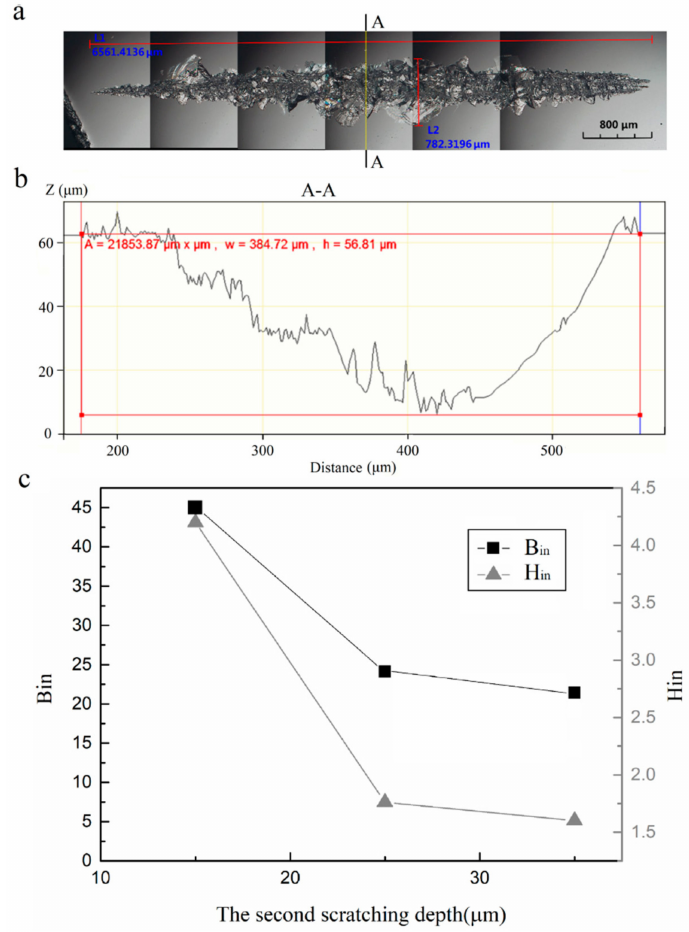
Figure 2. Three-dimension morphology of the groove after scratching by two diamond grain with di ff erent Z-axis spacings along the depth of cutting (DOC) direction, ( a ) morphology of the groove Iwith the ∆ d z of 25 µ m, ( b ) profile curve of Section A, and ( c ) bin and hin of twice scratching with di ff erent spacings in Z-axis direction for